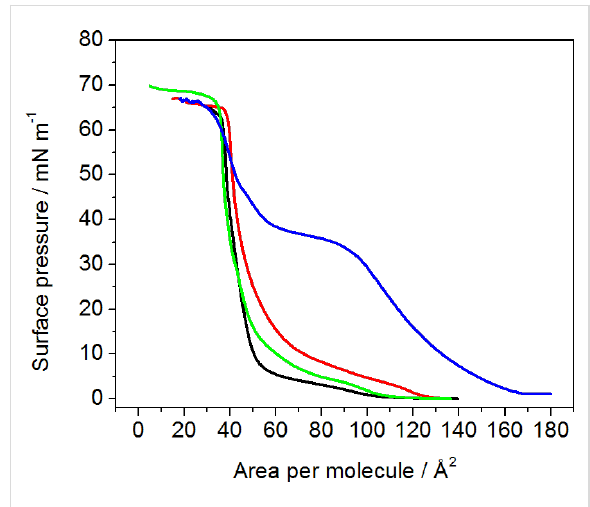
Figure 2: Surface pressure-area per molecule ( π –A) isotherms of DPPTE monolayer on water subphase (black), mixed layers of DPPTE:SWCNTs-DNR weight ratio of 1:5 (red), mixed layers of DPPTE/SWCNTs-DNR weight ratio of 10:1 (green), DPPTE mono- layer on subphase containing 10 − 5 DNR